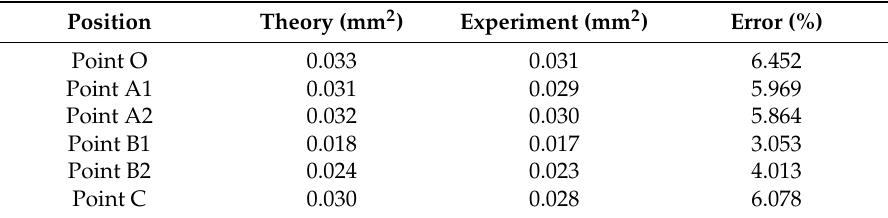
Table 5. Comparison of variance value of displacement at measurement points.